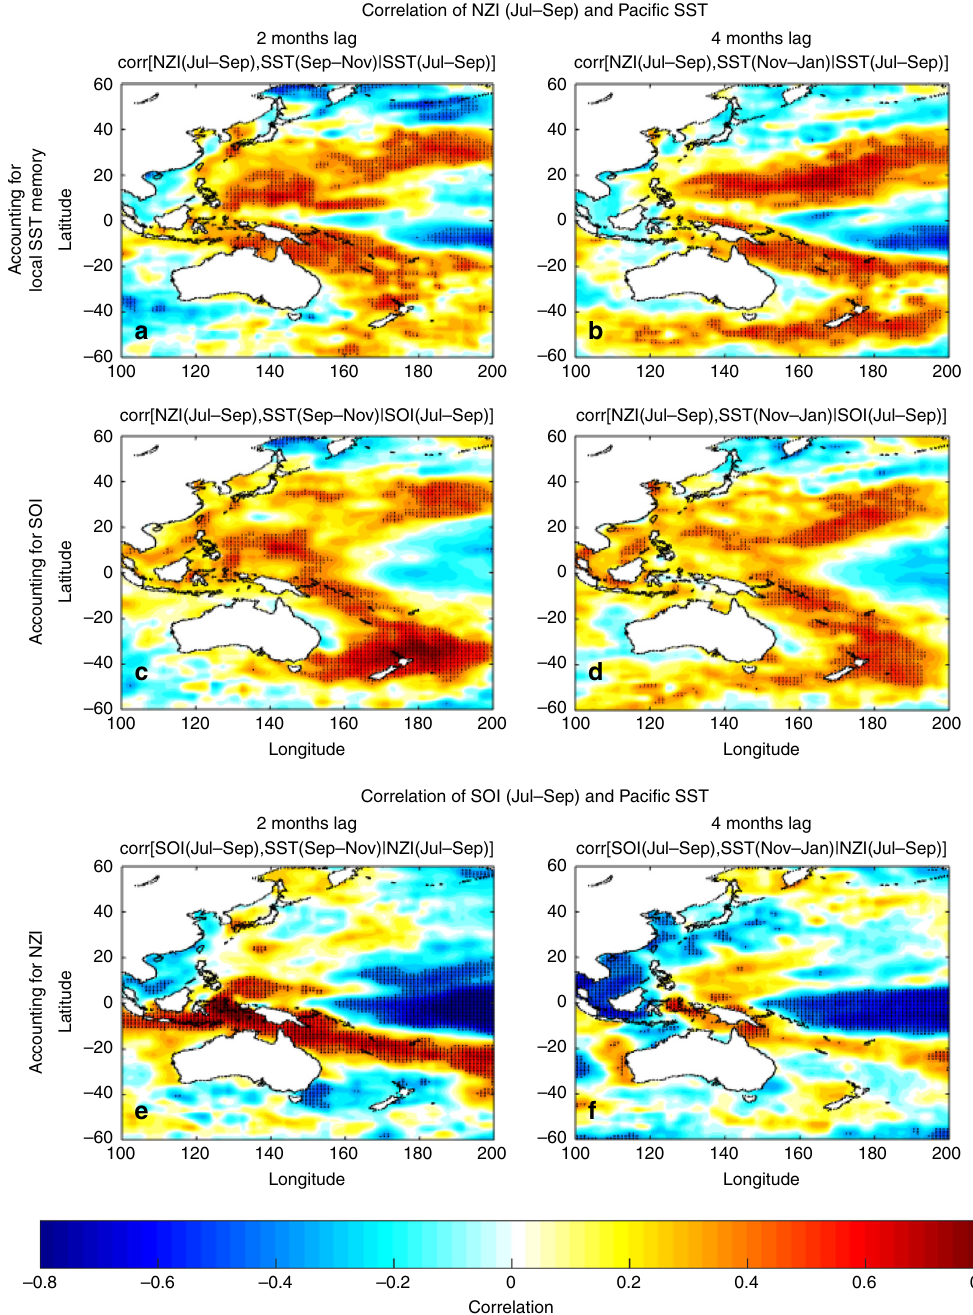
Fig. 1 NZI interhemispheric connection when accounting for local SST memory and ENSO in 1982 – 2015. a Correlation map of NZI during Jul – Sep and Paci fi c SST during Sep – Nov, after accounting for the SST memory in each grid point. Before calculating correlations all series were detrended. Black dots indicate statistical signi fi cance at a = 0.05. b Same as in a , but using SST during Nov – Jan. c , d Same as in a – b , but after accounting for the Southern Oscillation Index (SOI). e , f Same as in c – d , but SOI is correlated with Paci fi c SST, after accounting for the NZI. It is evident that NZI correlations with SST in the northwestern Paci fi c remain high and statistically signi fi cant even after accounting for local SST memory and/or SOI. In contrast, when accounting for NZI, correlations of SOI with SST in the northwestern Paci fi c are not statistically signi fi